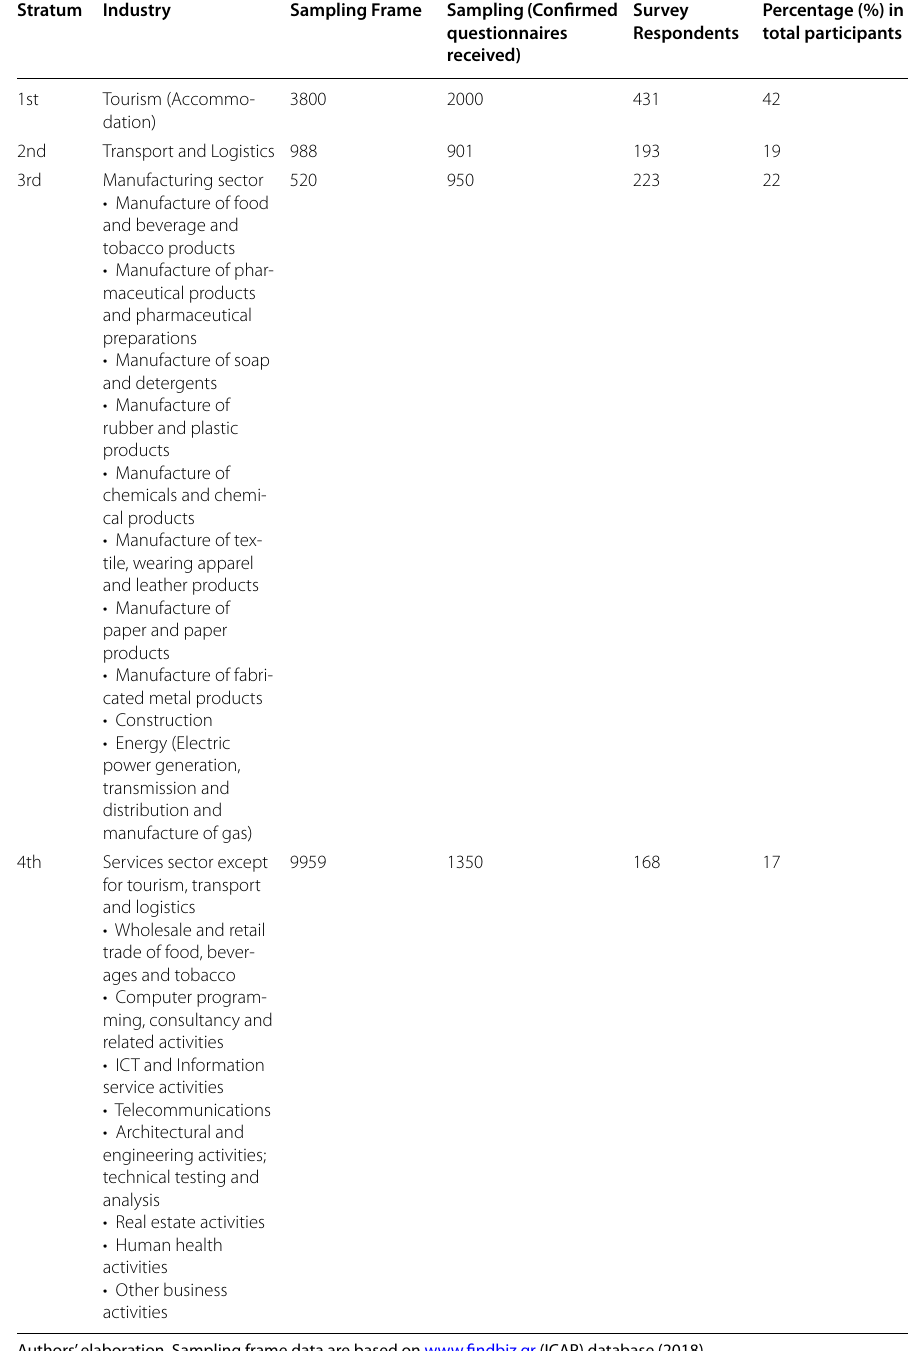
Table 1 Sampling frame, sample and survey